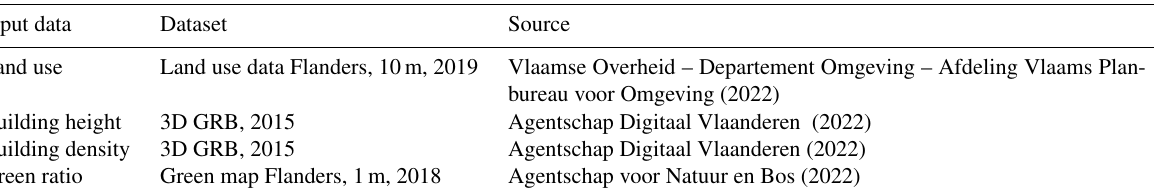
Table B1. Input data used for the creation of the LCZ map.